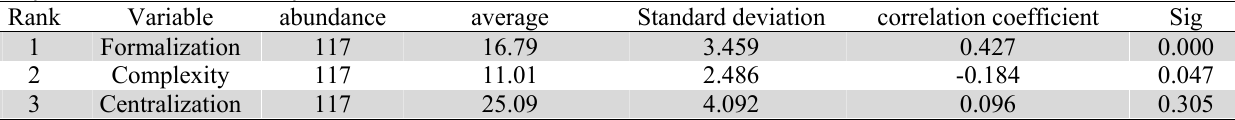
Prioritizing the structural dimensions according to their effect on the effectiveness of strategies in Payam-e-noor